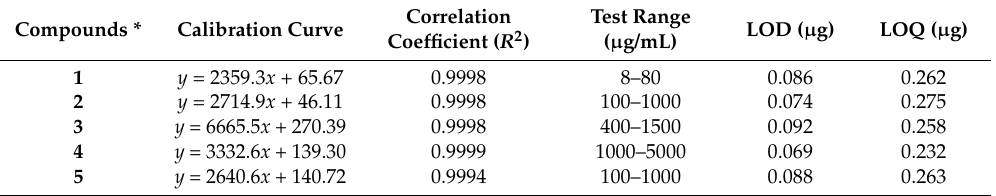
Table 3. Calibration curves and LODs for the five less polar ginsenosides.